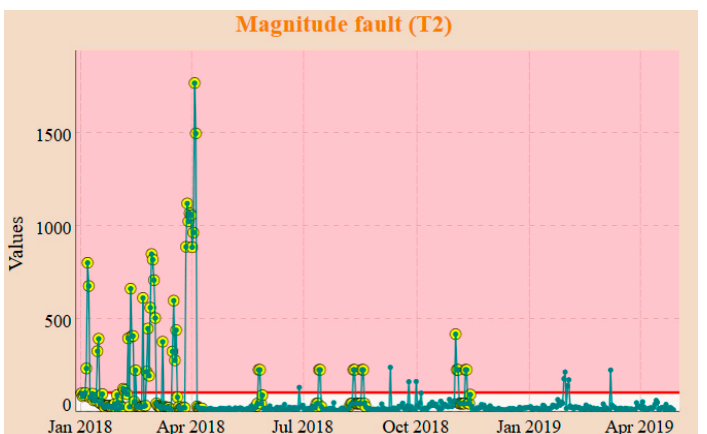
Figure 6. T 2 index for working days (from 1 January 2018 to end April 2019), each blue point represents a day. The red line represents the statistical threshold and points in the red area are abnormal days. Days circled in yellow present empty registers.